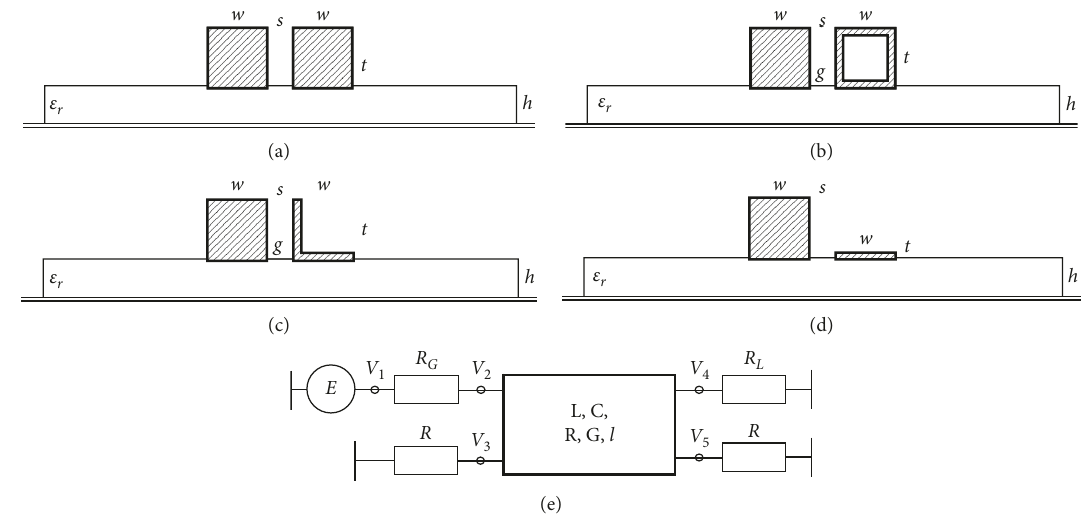
Figure 2: Cross-sections of the MF with passive conductors: (a) solid, (b) hollow, (c) corner, (d) thin, and their (e) equivalent